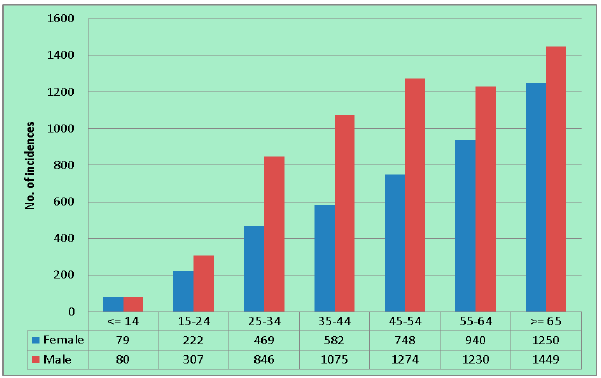
Figure 3. Number of total incidences by age group and gender during 2004–2008.